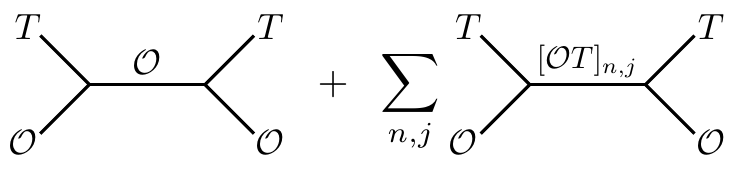
Figure 4 . Leading contributions to the four-point function hO TT Oi in CFTs with large N and large gap. When integrating to obtain correlators of the global light-ray operators L m , the contribution from double-trace operators (right) vanishes, leaving only the O